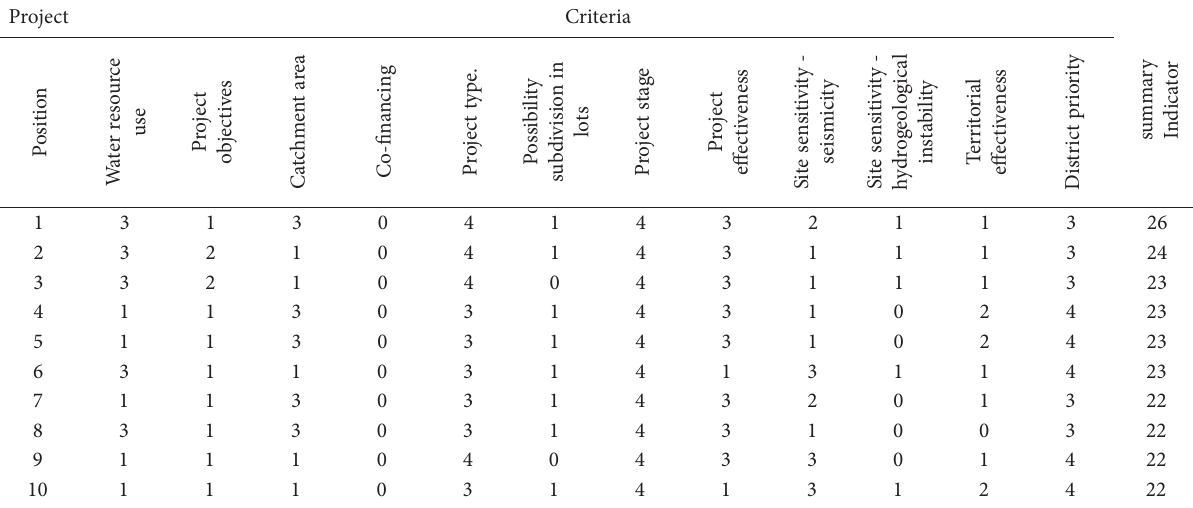
Table 4. List of scores awarded to selected projects for each criterion: evaluation matrix. Project Criteria